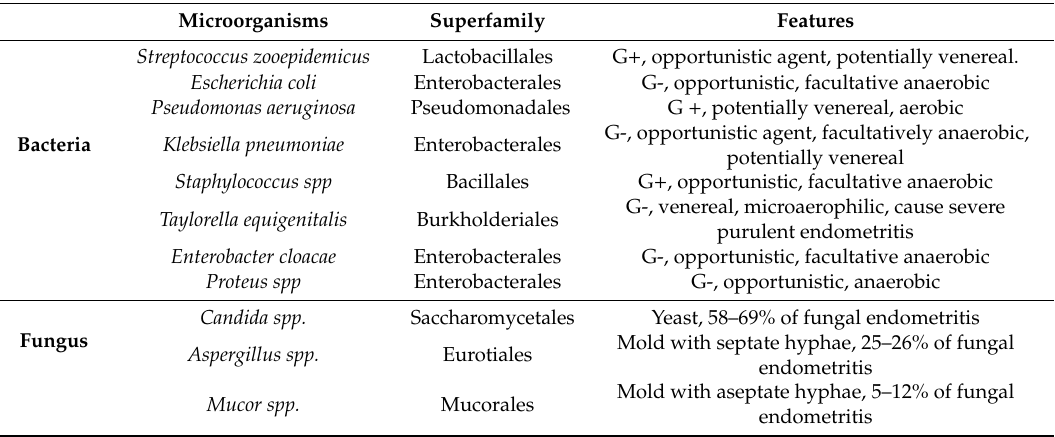
Table 1. Common bacteria and fungi isolated from the uteruses of mares su ff ering from endometritis. G + : Gram-positive; G-: